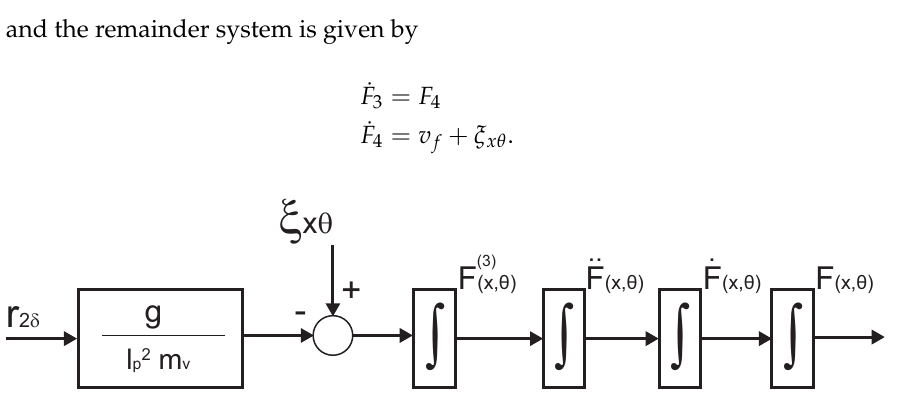
Figure 3. Cascade structure of ( x , θ ) sub −